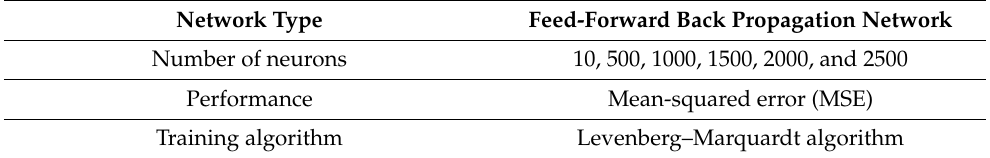
Table 1. Network